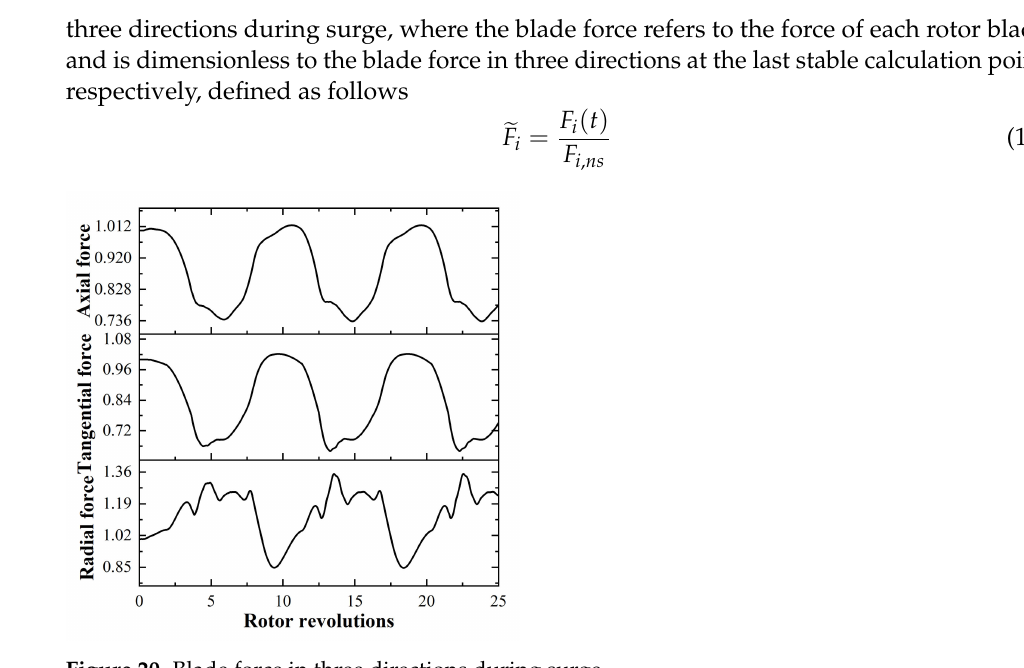
Figure 20. Blade force in three directions during surge.